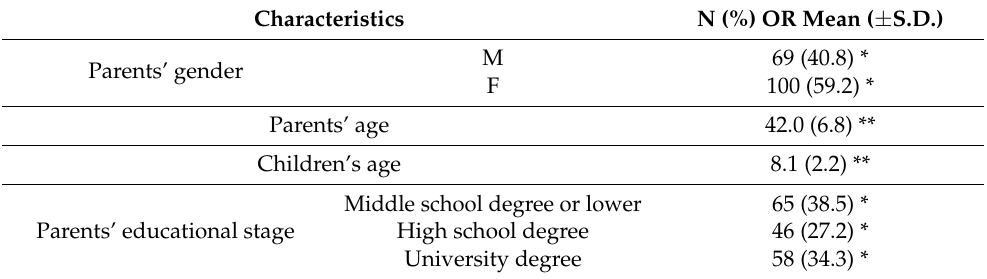
Table 1. Socio-demographic variables.